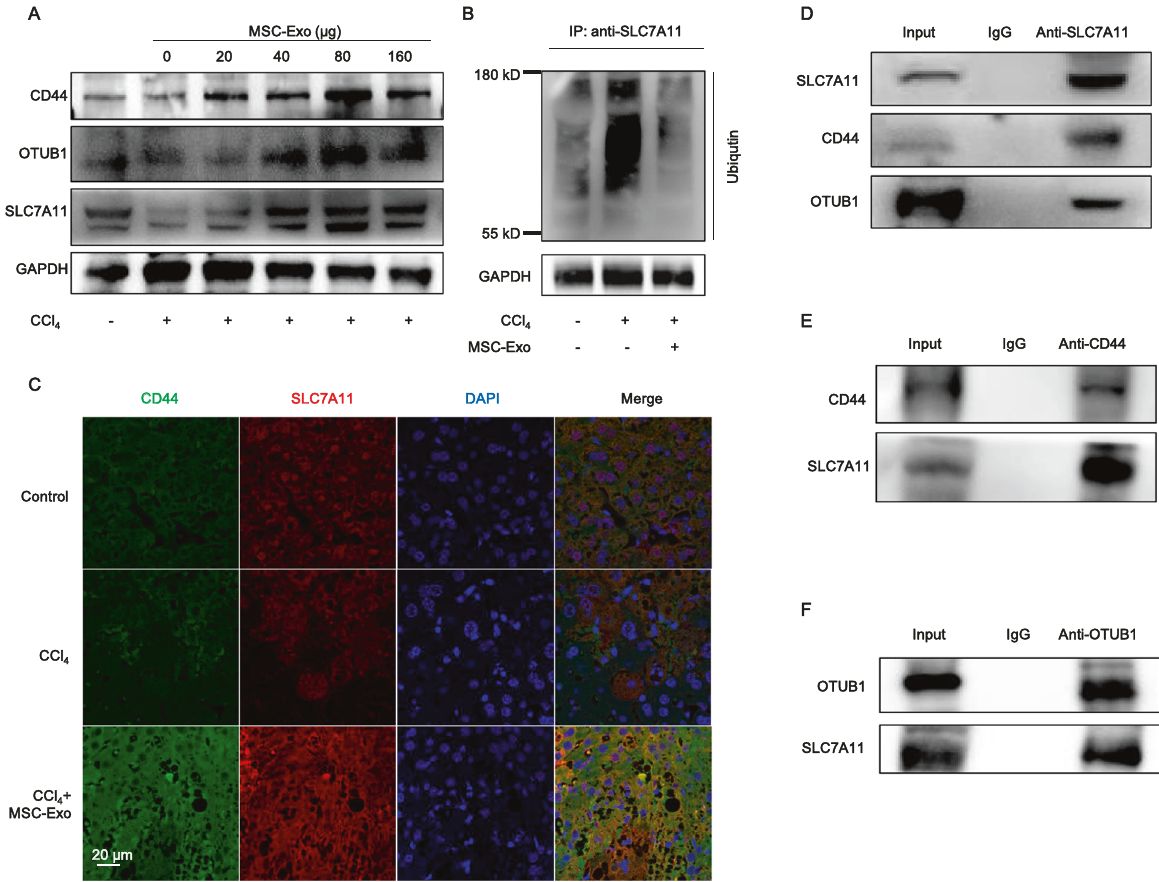
Fig. 6 MSC-Exo protected against ferroptosis via the stabilization of SLC7A11 in ALI. A CD44, OTUB1, and SLC7A11 protein levels in CCl 4 - induced acute injured hepatocytes treated with 0, 20, 40, 80, and 160 µg MSC-Exo were detected by WB analysis. B CCl 4 -induced ALI increased ubiquitination of SLC7A11 in hepatocytes, and this effect was downregulated following MSC-Exo treatment. C Immuno fl uorescence assay was used to detect the protein levels of CD44 and SLC7A11 in liver tissues. D WB analysis of CD44 and OTUB1 after co-immunoprecipitation of anti-SLC7A11 from liver tissue in CCl 4 group treated with MSC-Exo. One percent of the sample was loaded as input. E WB analysis of SLC7A11 after co-immunoprecipitation of anti-CD44 from liver tissue in CCl 4 group treated with MSC-Exo. One percent of the sample was loaded as input. F WB analysis of SLC7A11 after co-immunoprecipitation of anti-OTUB1 from liver tissue in CCl 4 group treated with MSC-Exo. One percent of the sample was loaded as input. Signi fi cance was calculated by one-way ANOVA with Tukey ’ s post hoc test. * p < 0.05 or ** p < 0.001 indicated a signi fi cant difference between